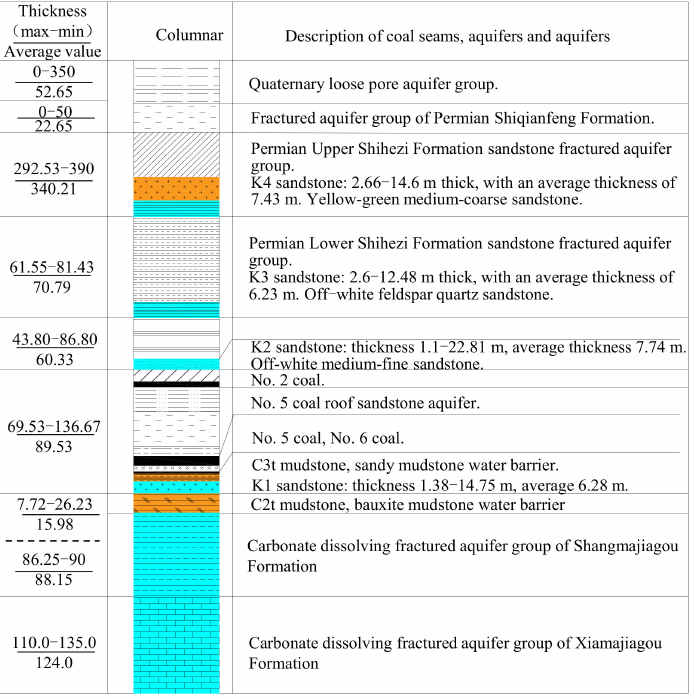
Figure 1. The positional relationship among the main coal seam, aquifer, and water-resisting